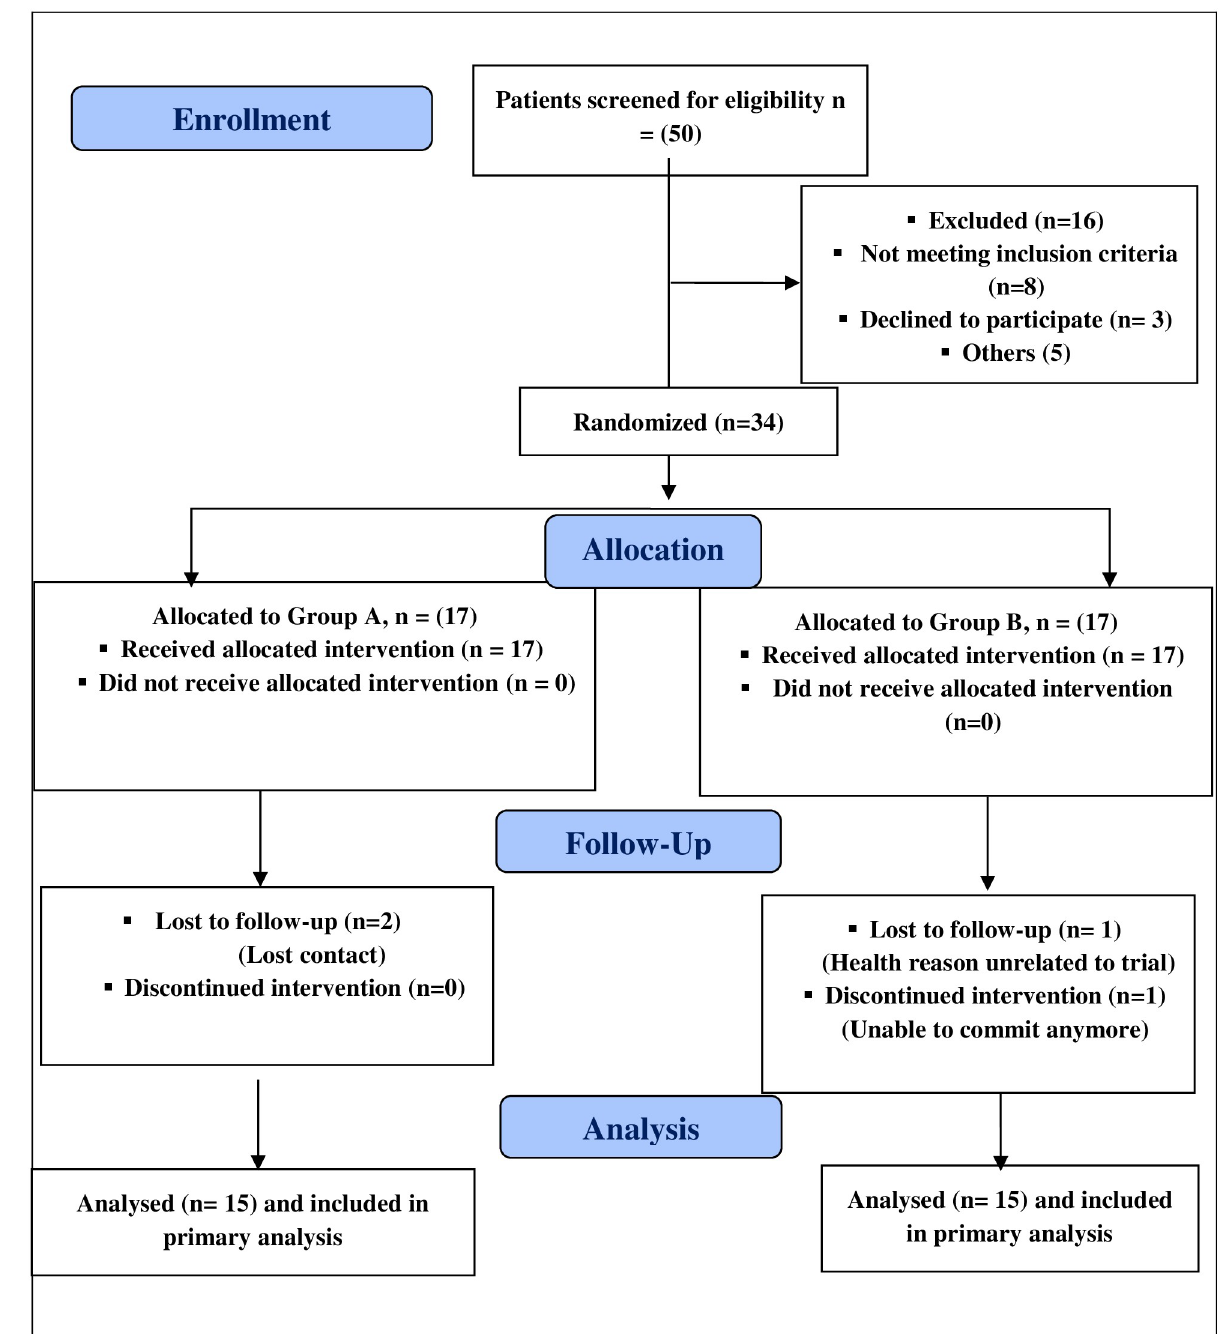
Fig 1. Consort diagram for the